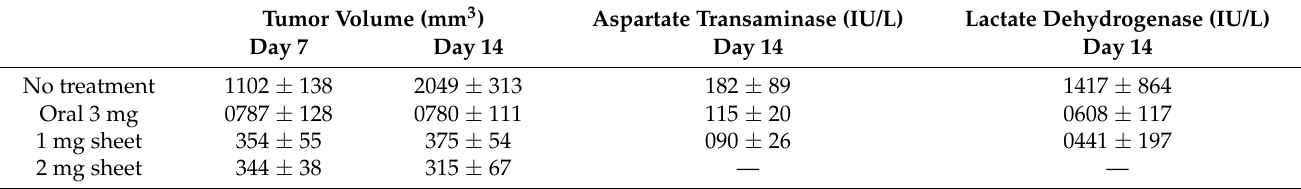
Table 2. Tumor volume and markers of liver injury in the